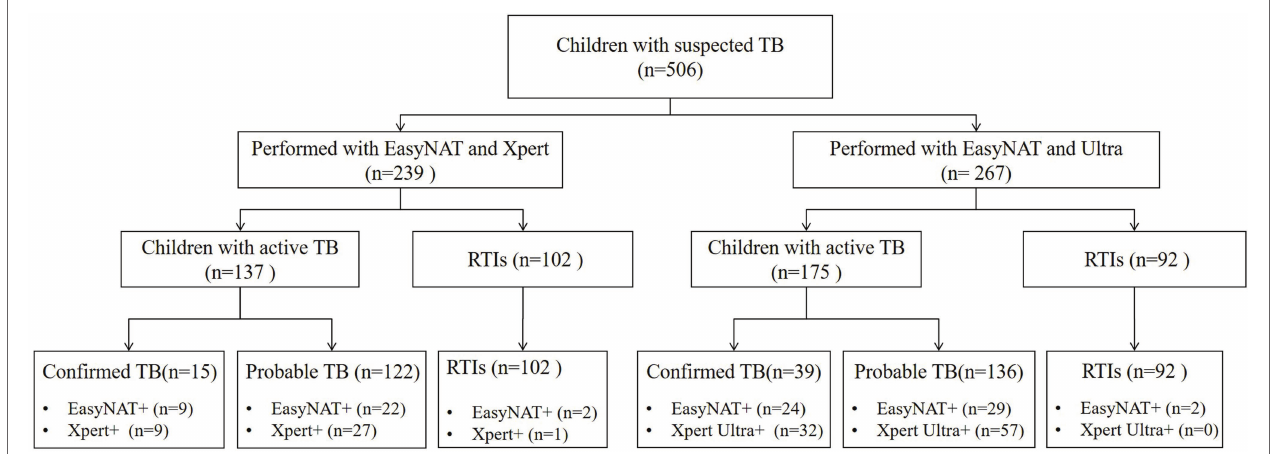
FIGURE 1 | Flow chart of the study population. TB, tuberculosis; RTIs, respiratory tract infections; EasyNAT, EasyNAT MTC assay; Xpert, Xpert MTB/RIF; and Ultra, Xpert MTB/RIF Ultra.